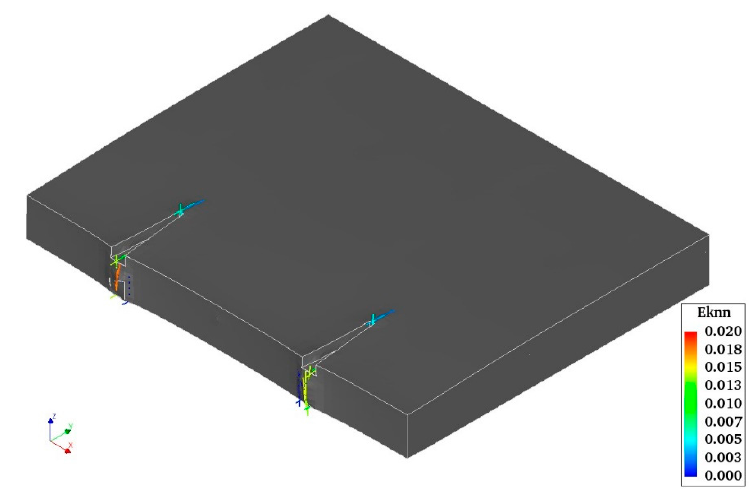
Figure 18. Crack initiation in ARCP-1 from the saw-cuts.